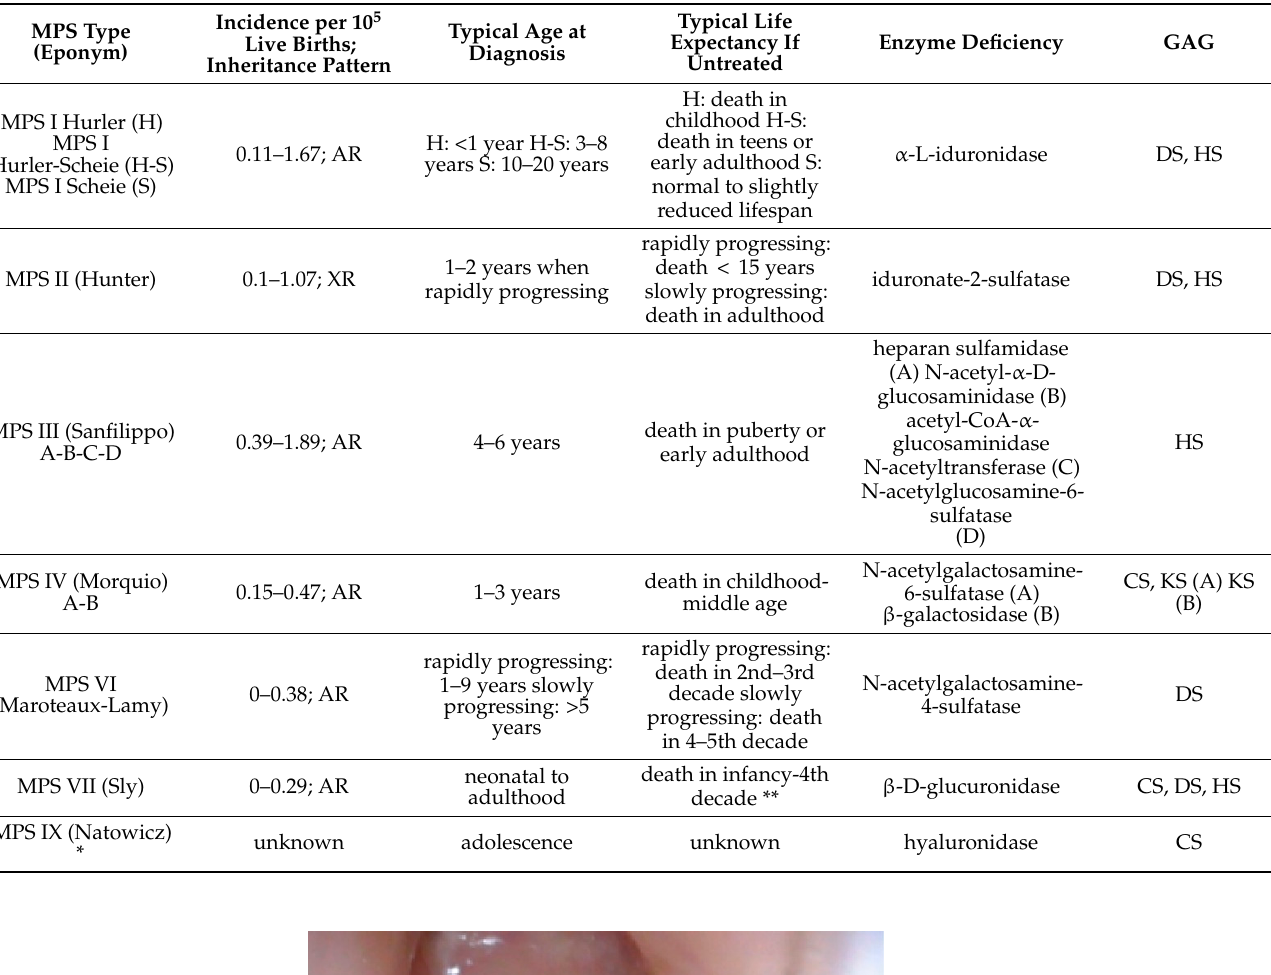
Table 1. Various types of MPS; reproduced with permission from Braunlin et al. [8], who compiled data from Neufeld et al. [9] and Valayannopoulos et al. [10]. AR: autosomal recessive; CS: chondroitin sulfate; DS: dermatan sulfate; GAG: glycosaminoglycan; H: Hurler syndrome; HS: heparan sulfate; H-S: Hurler–Scheie syndrome; KS: keratan sulfate; S: Scheie syndrome; XR: X-linked recessive. * only 1 patient reported in the literature (Natowicz et al. 1996); ** death can occur in utero with hydrops fetalis.